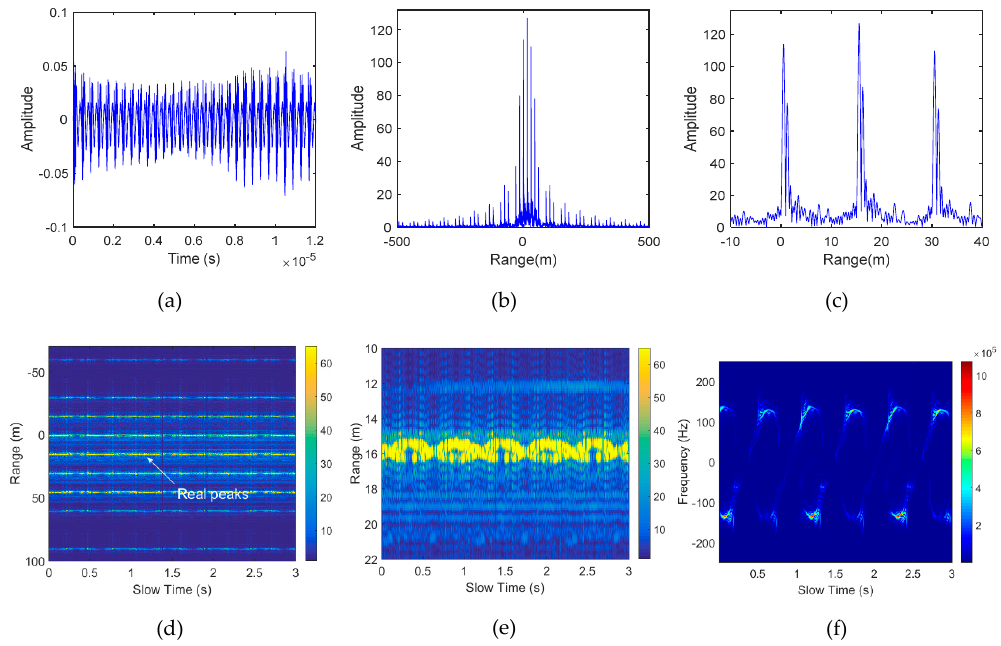
Figure 7. The ITR echo and micro Doppler extraction results ( B = 300 MHz, T s = 0.4 μ s). ( a ) The ITR echo. ( b ) HRRP of ITR echo. ( c ) Magnification of HRRP. ( d ) Range slow-time 2D image. ( e ) Magnification of Range slow-time 2D image. ( f ) Time-frequency